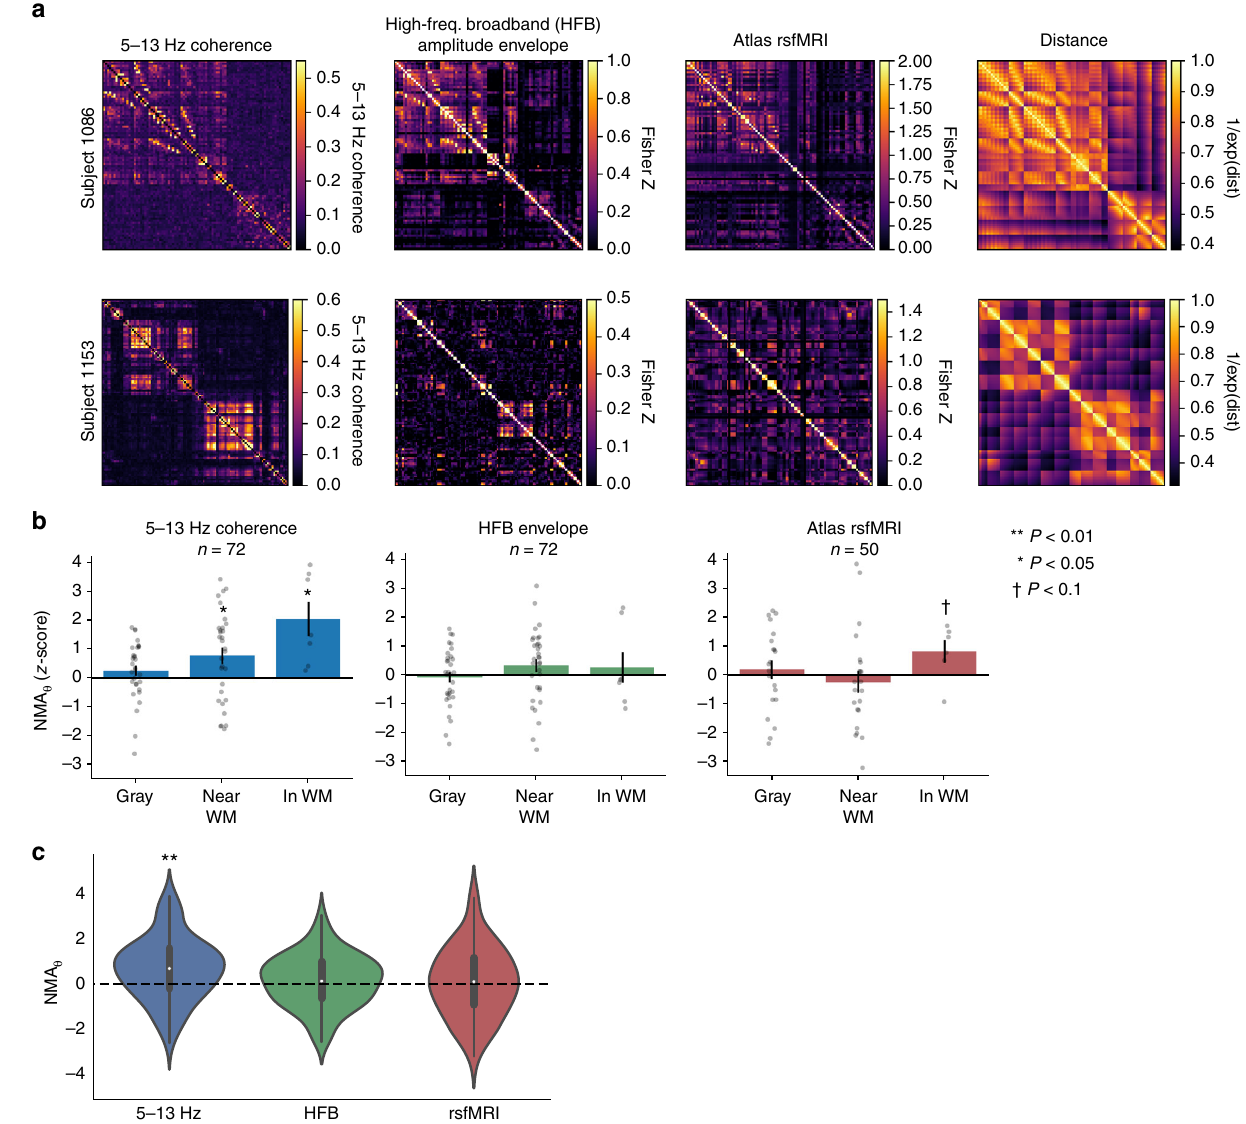
Fig. 5 Alternative measures of connectivity. a Example adjacency matrices for two subjects, re fl ecting functional connectivity from low-frequency (5 – 13 Hz) coherence, correlated high-frequency broadband envelope (HFB; 50 – 200 Hz), and atlas-based fMRI (rsfMRI). Matrices are organized as in Fig. 2a. For reference, adjacency matrices of linearized Euclidean distance are shown at the far right. Colormap ranges are selected to visually emphasize network structure. Values in the HFB envelope and rsfMRI networks are Fisher z -transformed correlation coef fi cients. b NMA θ is computed as in Figs. 2 and 3, using adjacency matrices for each of the three measures. NMA θ was binned by distance from white matter, organized as in Fig. 3b. In addition to signi fi cant NMA θ in and near white matter using 5 – 13 Hz coherence networks ( P < 0.05), we noted marginally signi fi cant NMA θ in white matter using atlas-based rsfMRI networks ( P < 0.1). c Distribution of NMA θ for all stimulation electrodes regardless of distance from white matter. NMA θ is signi fi cantly greater than zero at the group level for 5 – 13 Hz coherence (one-sample t -test, t (71) = 4.18, P = 8.2 × 10 – 5 ). Note that the total count of stimulation electrodes is lower for rsfMRI connectivity ( n = 50) analyses, due to subjects where atlas-based rsfMRI could not be extracted for a stimulation electrode; see Methods for details. Error bars show ±1 SEM; * P < 0.05; ** P <